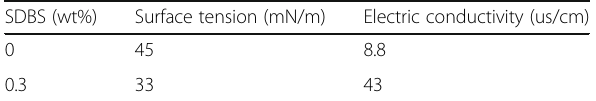
Table 1 Surface tension and electrical conductivity of PVA solution without and with SDBS SDBS